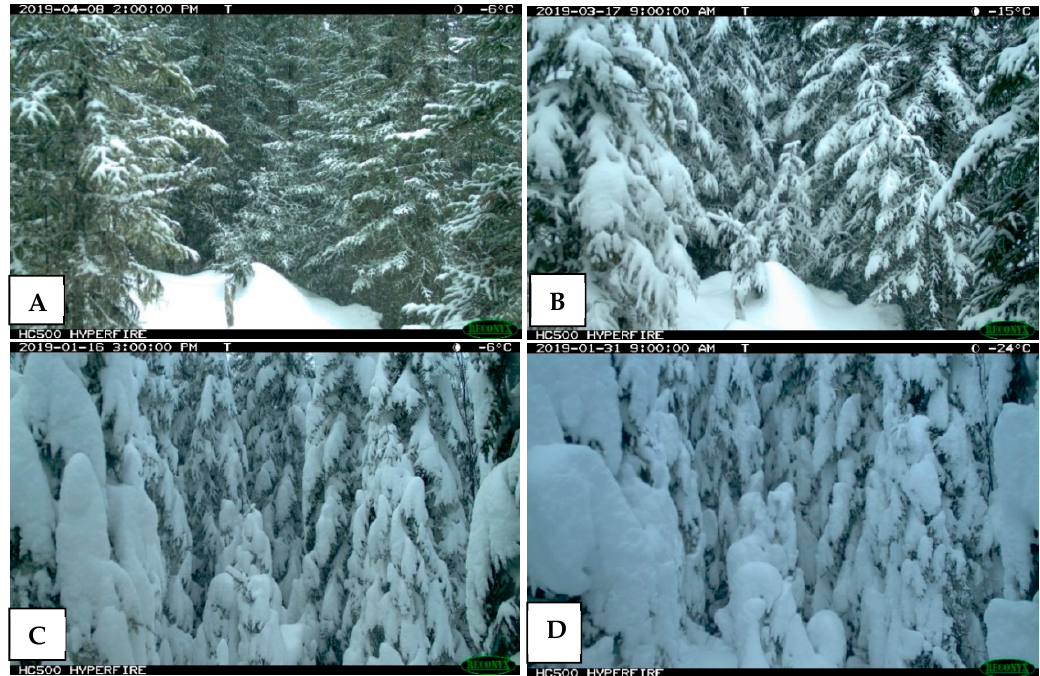
Figure 2. Evaluation of the snow thickness on the crowns. ( A ) 0 [0–5 cm] traces of snow on the crowns; ( B ) 10 [5–15 cm] the snow sticks to the branches, the branches start to bend; ( C ) 20 [15–25 cm] snow clumps everywhere and the branches are fully bent; and ( D ) 30 [>25 cm] big snow clumps and bridges between trees.